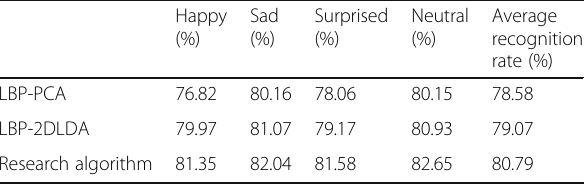
Table 3 Recognition rate of each algorithm in Yale face